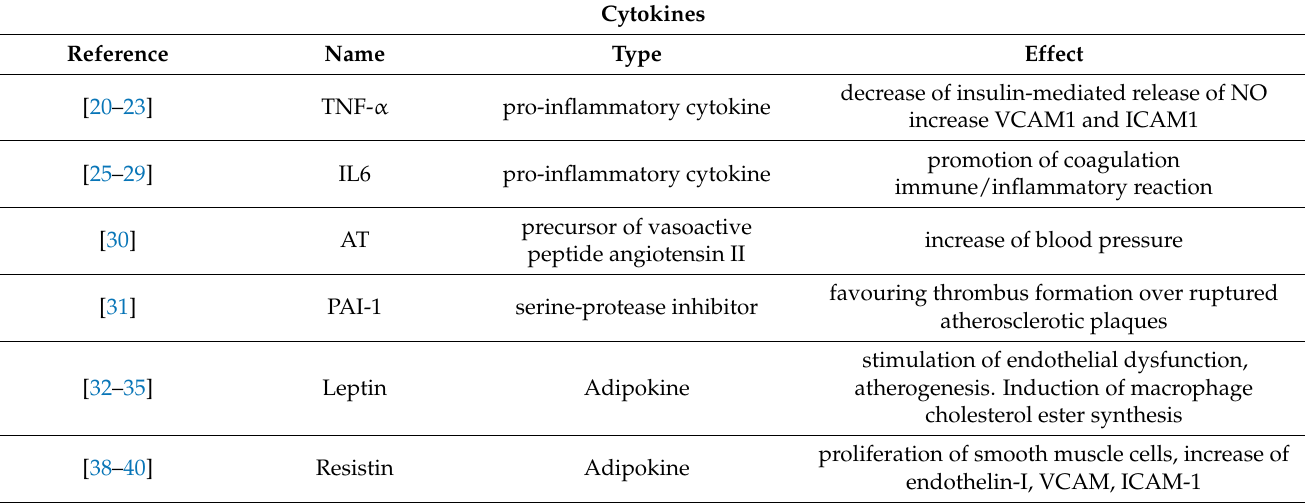
Table 1. Cytokines involved in cardiovascular